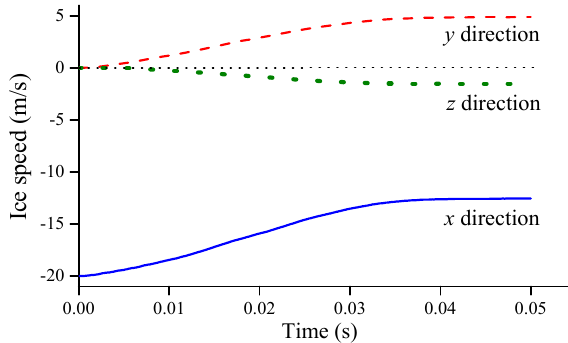
Figure 13. Variations of ice speed in three directions with time.